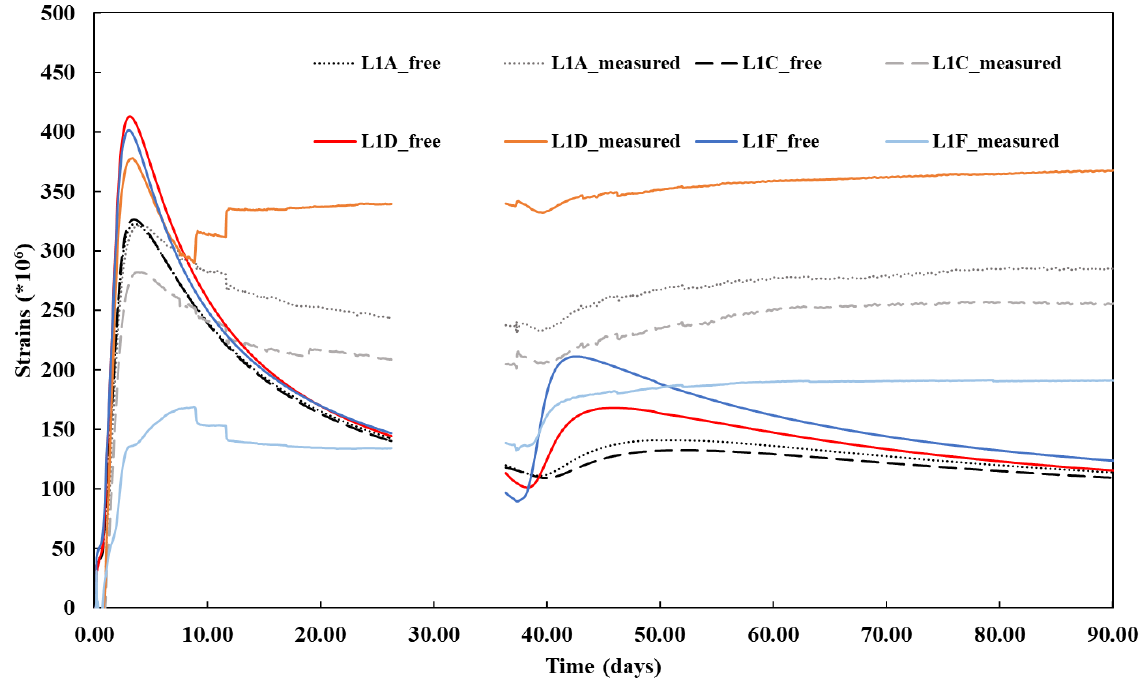
Figure 9: Absolute values of recorded strains and free thermal strains in time for